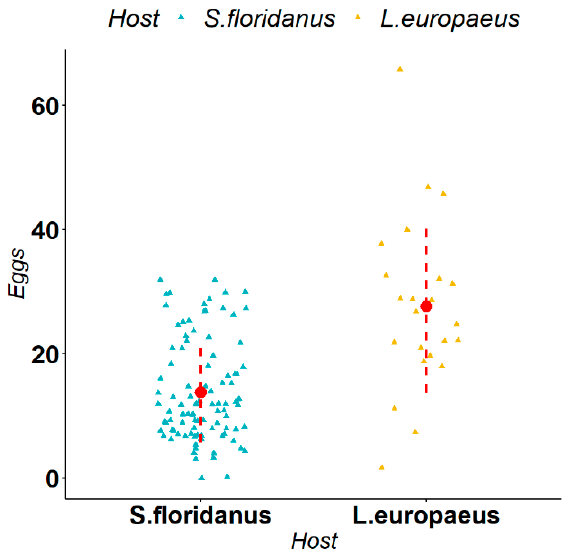
Figure 5. Comparison of female fertility (i.e., in utero count of the number of eggs) of Trichostrongylus calcaratus in Lepus europaeus and Sylvilagus floridanus . The triangles represent the single observations, the red dots represent the average values, while the red dashed lines represent the standard deviation.